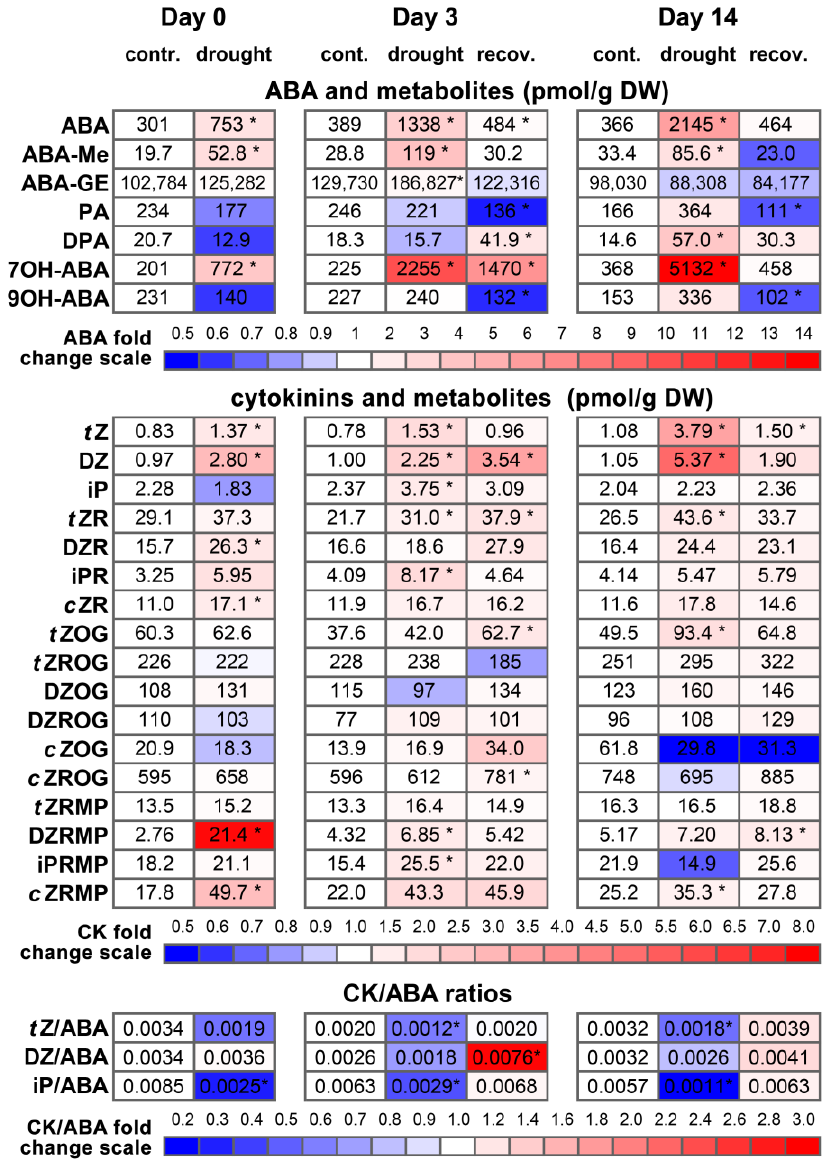
Figure 3. Heatmap analysis of the contents of abscisic acid, cytokinins and their metabolites and of CK/ABA ratios in the needles of plants in Experiment 1. The contents of the compounds in control plants at each time point were taken as 1.0 (white); the relative increase is indicated in red and the relative decrease is indicated in blue. ABA, abscisic acid; ABA-Me, ABA-methyl ester; ABA-GE, ABA-glucosyl ester; PA, phaseic acid; DPA, dihydrophaseic acid; 7OH-ABA, 7-hydroxy-ABA; 9OH-ABA, 9-hydroxy-ABA; t Z, trans -zeatin; DZ, dihydrozeatin; iP, N 6 -( ∆ 2 -isopentenyl)adenine; t ZR, trans -zeatin 9-riboside; DZR, dihydrozeatin 9-riboside; iPR, N 6 - ( ∆ 2 -isopentenyl)adenosine; c ZR, cis -zeatin 9-riboside; t ZOG, trans -zeatin O-glucoside; t ZROG, trans - zeatin 9-riboside O-glucoside; DZOG, dihydrozeatin O-glucoside; DZROG, dihydrozeatin 9-riboside O-glucoside; c ZOG, cis -zeatin O-glucoside; c ZROG, cis -zeatin 9-riboside O-glucoside; t ZRMP, trans - zeatin 9-riboside-5 (cid:48) -monophosphate; DZRMP, dihydrozeatin 9-riboside-5 (cid:48) -monophosphate; iPRMP, N 6 -( ∆ 2 -isopentenyl)adenosine-5 (cid:48) -monophosphate; c ZRMP, cis -zeatin 9-riboside-5 (cid:48) -monophosphate. Pairwise comparisons of the means were performed between control and drought-stressed and con- trol and recovering plants at each separate time point using Student’s t- test or Mann–Whitney rank sum test. Asterisks (*) denote significant differences at p < 0.05 between the control and experimental variants at each time